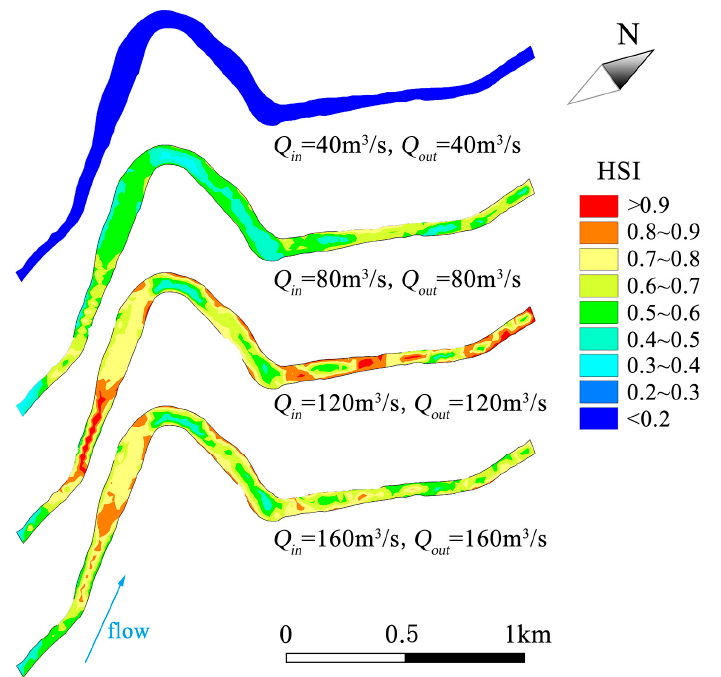
Figure 12. The spatial distribution of HSI under different inflow and outflow scenarios (inflow is equal to outflow).